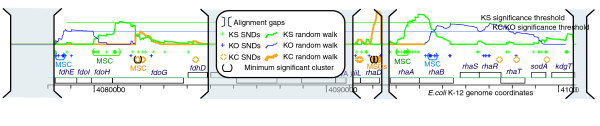
Mosaic operons and genes. Three of six rha genes (rhaB, rhaA, and rhaD) belong to an operon on the reverse strand. This operon is unusual because well-defined recombination events clearly fall within gene boundaries; rhaD contains two dense KC clusters, whereas rhaA and rhaB contain predominantly KS and KO SNDs, respectively. In a nearby operon consisting of fdoG, fdoH, fdoI, and fdhE, there has been a KC intragenic recombination event with fdoG a mosaic, resulting from two recombination events, one of which is shared with fdoH.